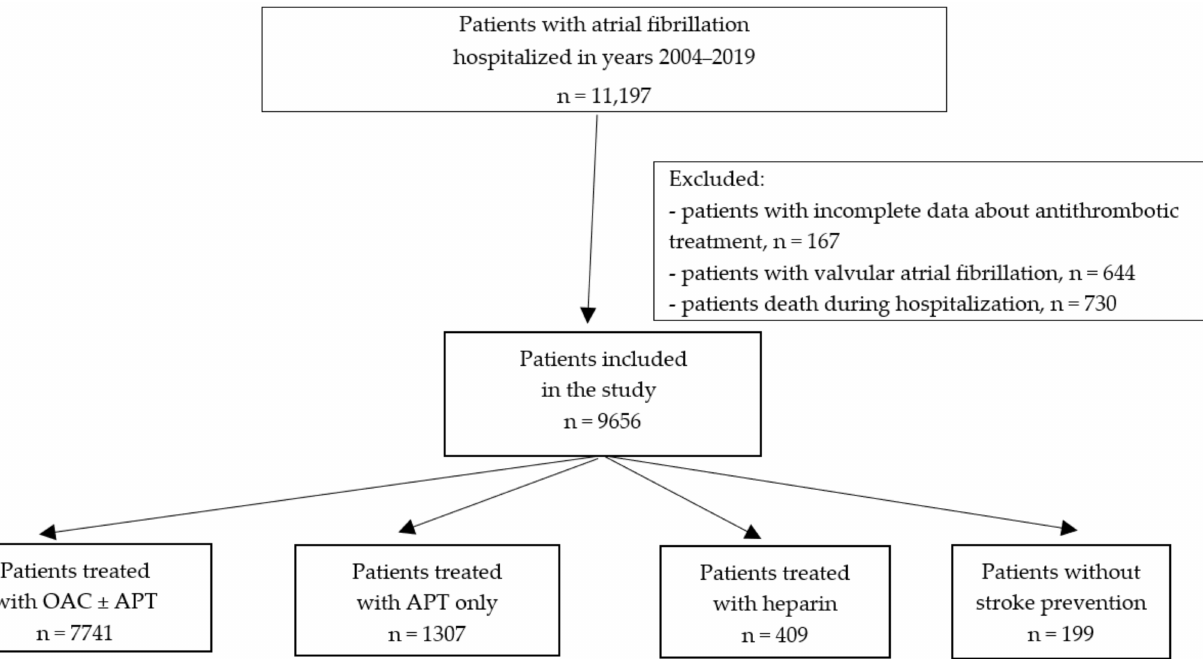
Figure 1. The flow chart of the study. Abbreviations: APT, antiplatelet drug, and OAC, oral